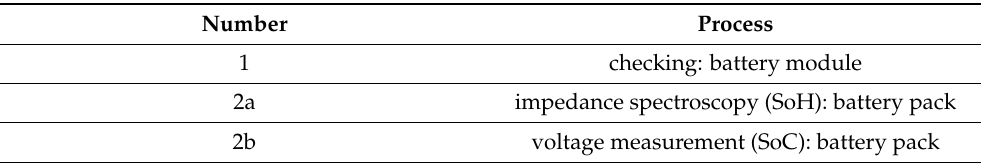
Table A11. Activities of the main processes “classification” and “disassembly”: status report battery modules.